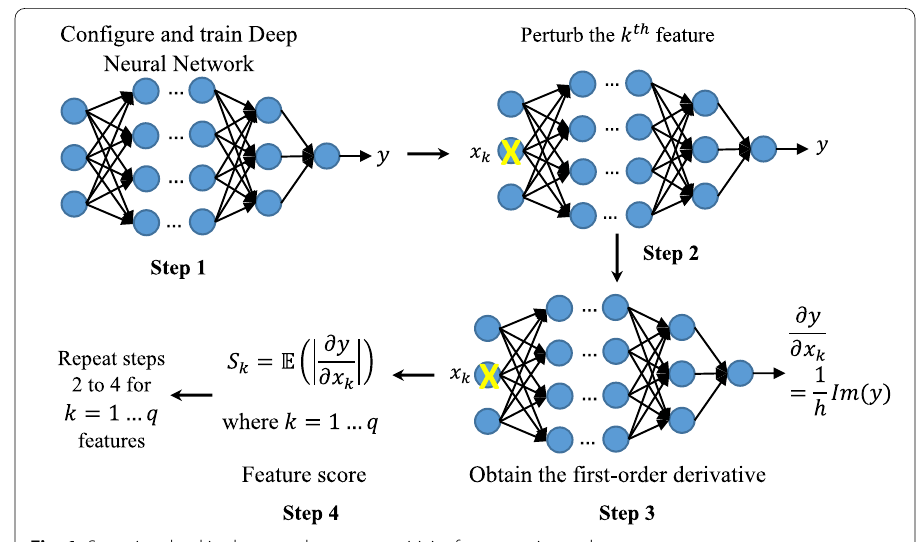
Fig. 1 Steps involved in the complex-step sensitivity for regression